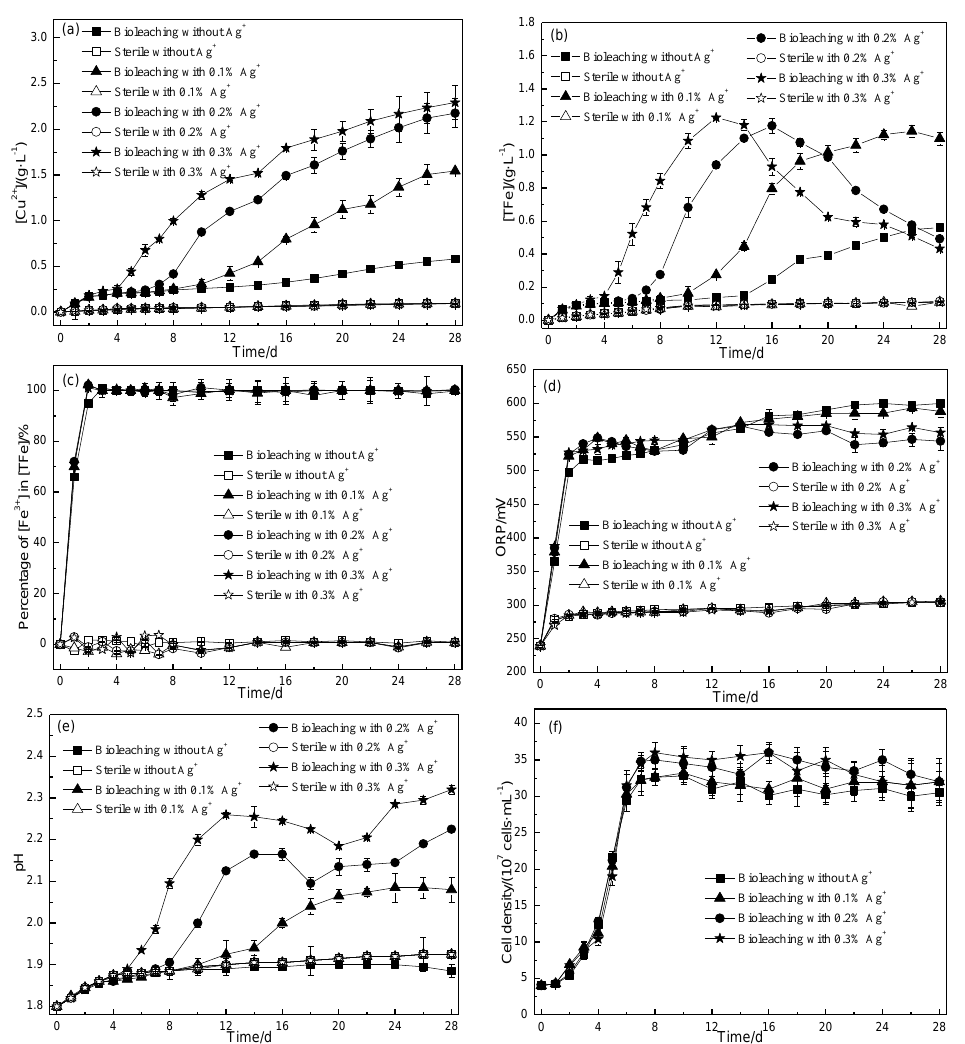
Figure 2. Leaching parameters of chalcopyrite by mesophilic culture and in sterile experiments, both at 30 °C with 0, 0.1%, 0.2% and 0.3% of Ag + . The leaching parameters were characterized by [Cu 2+ ] ( a ), [TFe] ( b ), percentages of [Fe 3+ ]/[TFe] ( c ), ORP values ( d ), pH values ( e ) and cell density ( f ).